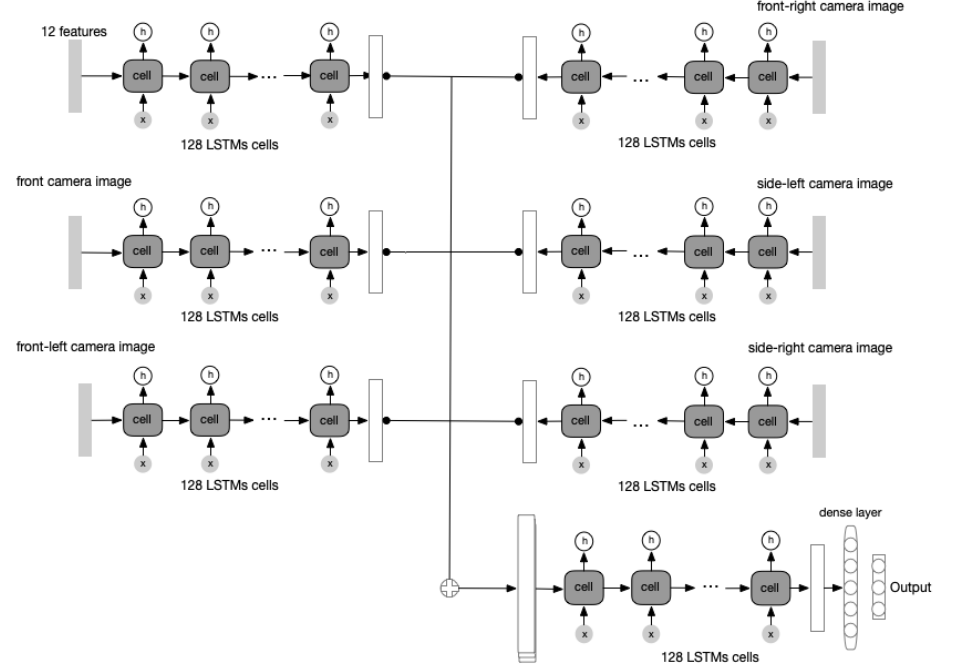
Figure 6. The first channel input is the 12 features for the observed 10 frames. The rest of the input is the 1576-dimensional representation of camera image from different views in the observed 10 frames. The outputs from all channels are concatenated to generate a representation that contains all information and key contents. The representation is stacked and fed in the same way as the basic model. The “encoder" module contains 128 LSTM-cells and the “decoder” module contains 128 LSTM-cells. The optimizer of this network is RMSprop with a learning rate 0.0001 and the dropout is used for each LSTM-cell with probability